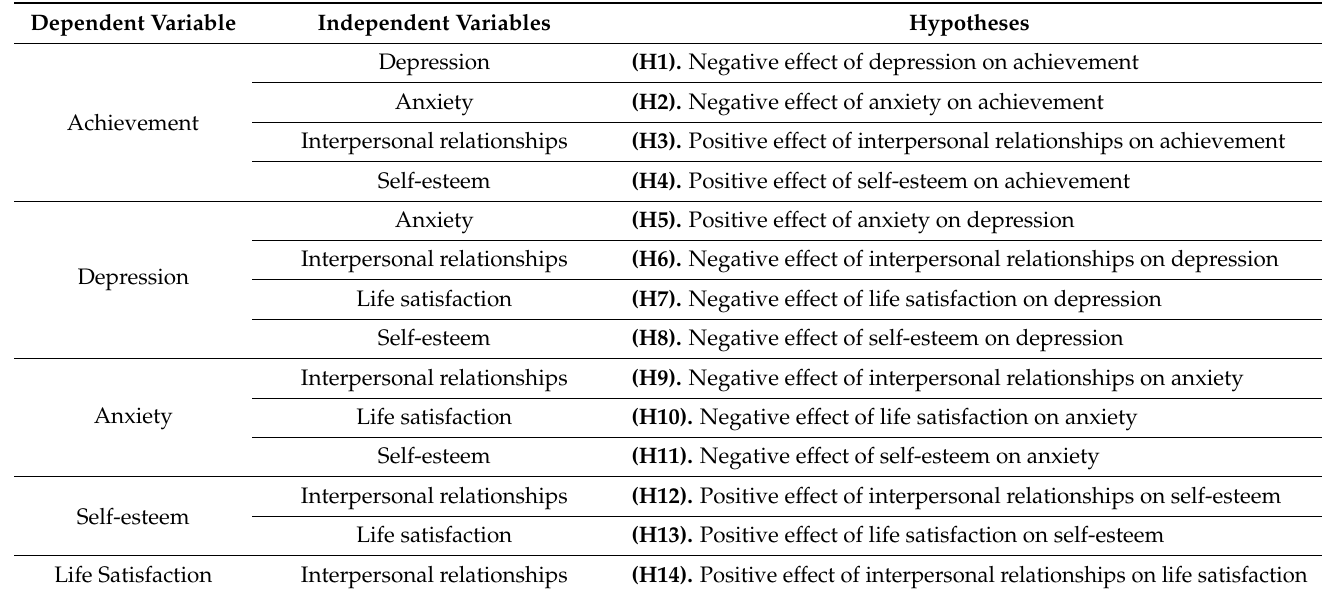
Table 1. Summarized results of the synthesis of factors influencing students’ achievement and